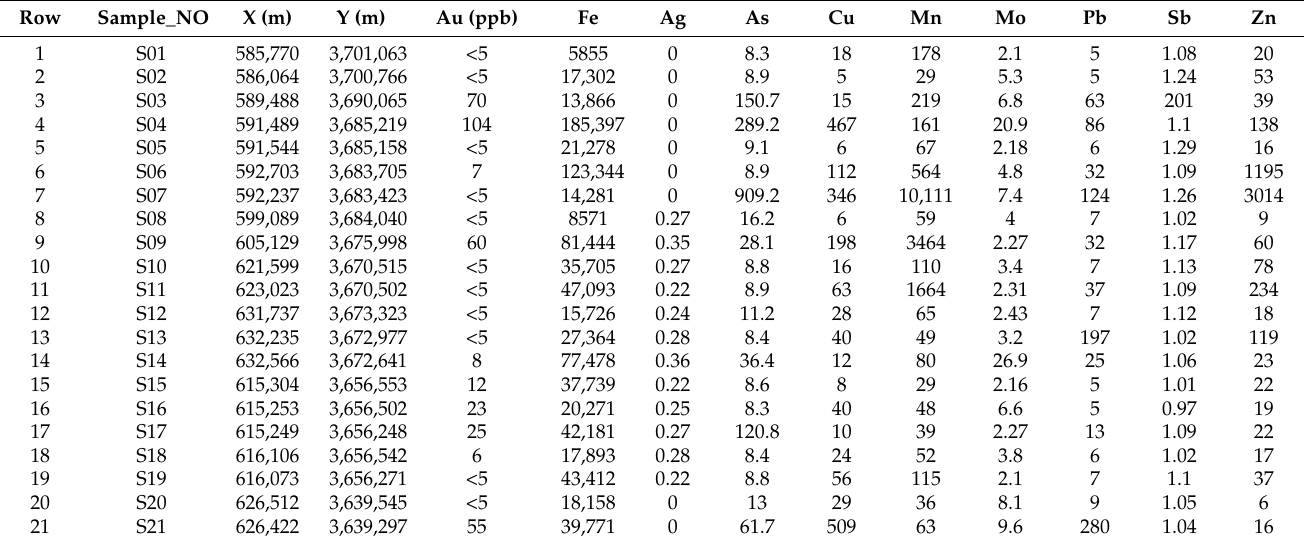
Table A1. ICP-MS analysis results of some significant elements (Au unit: part per billion, other element unit: part per million).